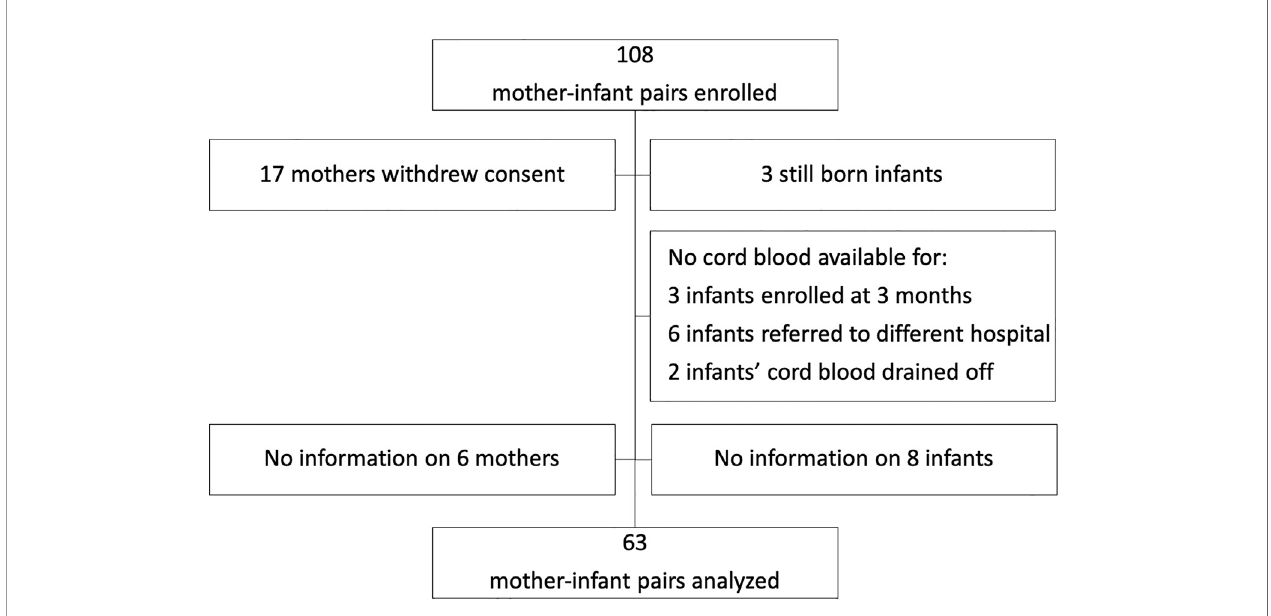
FIGURE 1 | Flowchart showing selection of paired maternal-infant